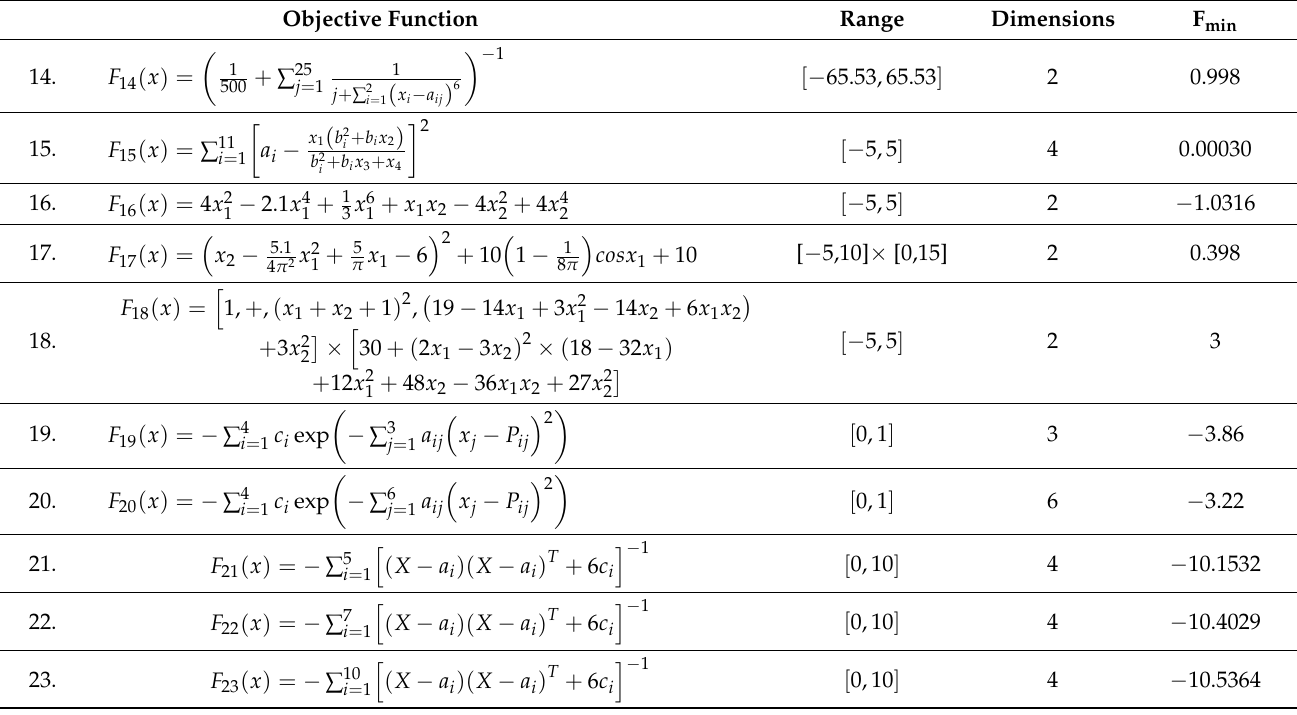
Table A3. Fixed dimensional Multimodal test